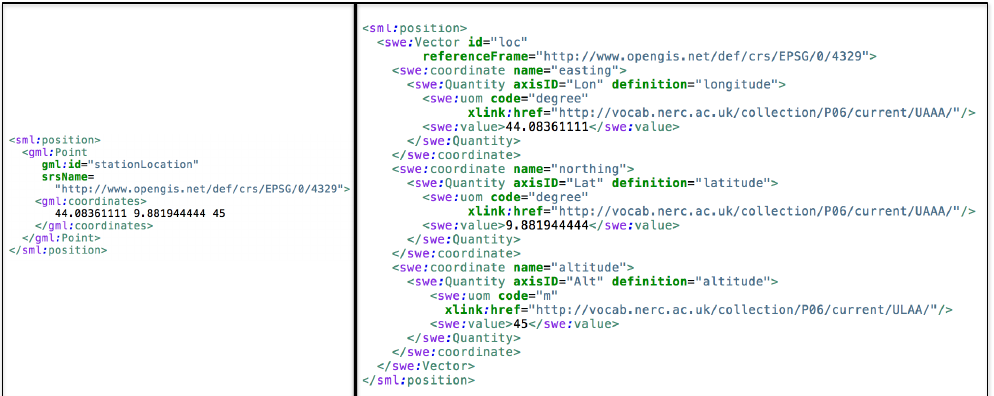
Figure 1. Example of two different SensorML chunks modeling the same